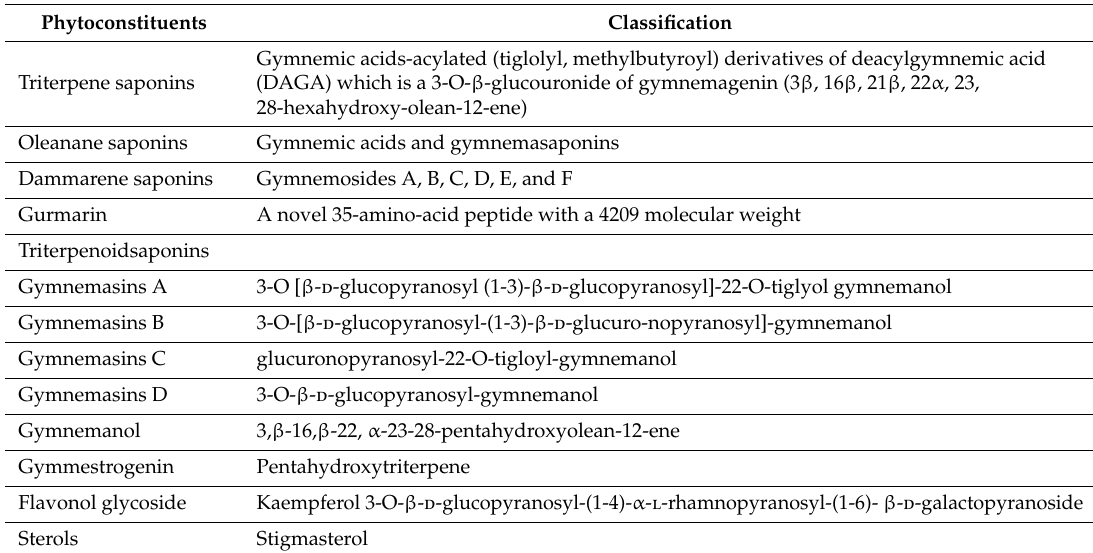
Table 3. Classification of phytoconstituents of Gymnema sylvestre .